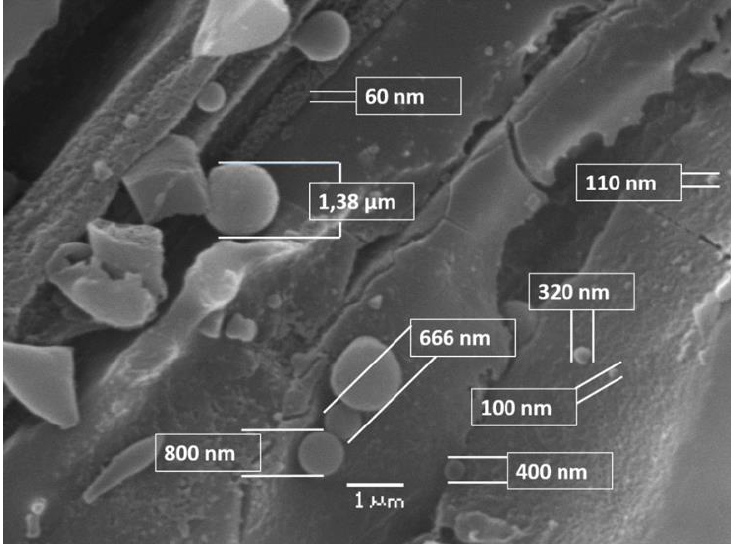
Figure 3. Diameter determination of lignin droplets formed during steam explosion pre-treatment at severity factor (S 0 ) of 10.42 using SEM image. The diameters range between 60 nm and 1380 nm. Bar size: 1 µm.